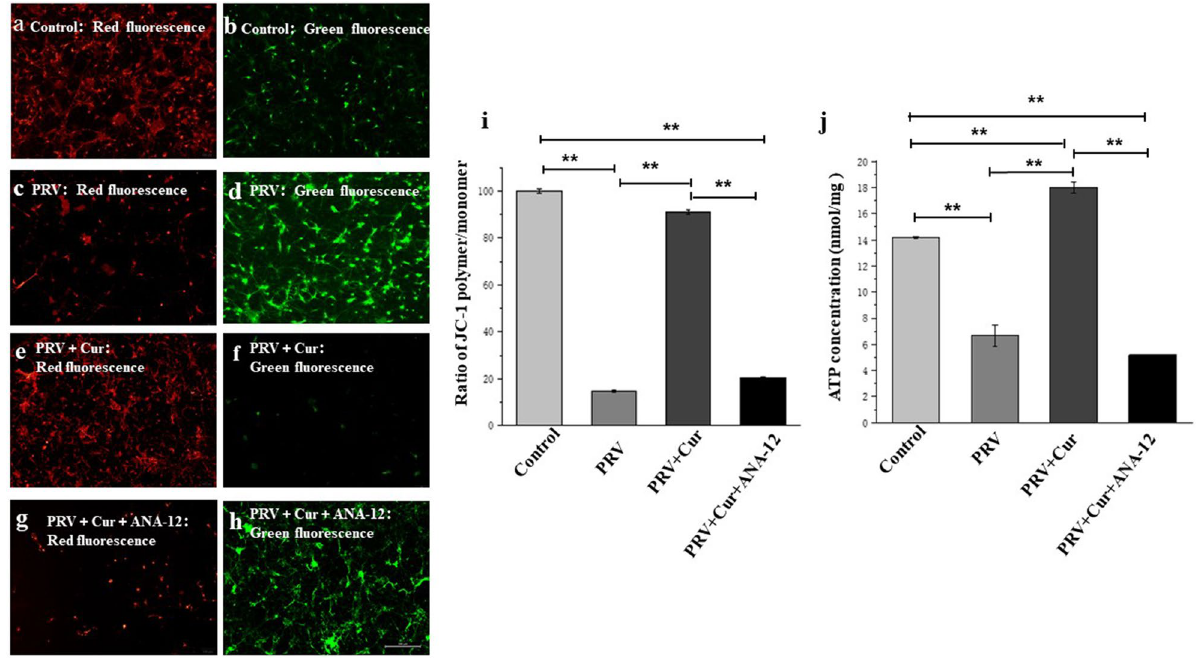
Figure 6. TrkB inhibitor, ANA-12 inhibited the protective effect of curcumin against mitochondrial dysfunction induced by pseudorabies virus (PRV). Red fluorescence represents the mitochondrial aggregate form of JC-1, indicating intact mitochondrial membrane potential. Green fluorescence represents the monomeric form of JC-1, indicating dissipation of mitochondrial membrane potential. ( a , b ) Control group; ( c , d ) PRV infection group; ( e , f ) PRV + Cur group; ( g , h ) PRV + Cur + ANA-12 group. ( i ) Quantitative analysis of the shift of mitochondrial orange-red fluorescence to green fluorescence among all groups. The individual red and green average fluorescence intensities are expressed as the ratio of red to green fluorescence. An increase in the bar indicates a shift in the fluorescence ratio correlating with an increase in mitochondrial depolarization. ( j ) ATP concentrations of hippocampal neurons. Cur curcumin. n = 3, represents three biological replicates, each performed in triplicate. *P < 0.05; **P < 0.01, based on one-way analysis of variance (ANOVA) followed by least significant difference (LSD) post hoc test for multiple